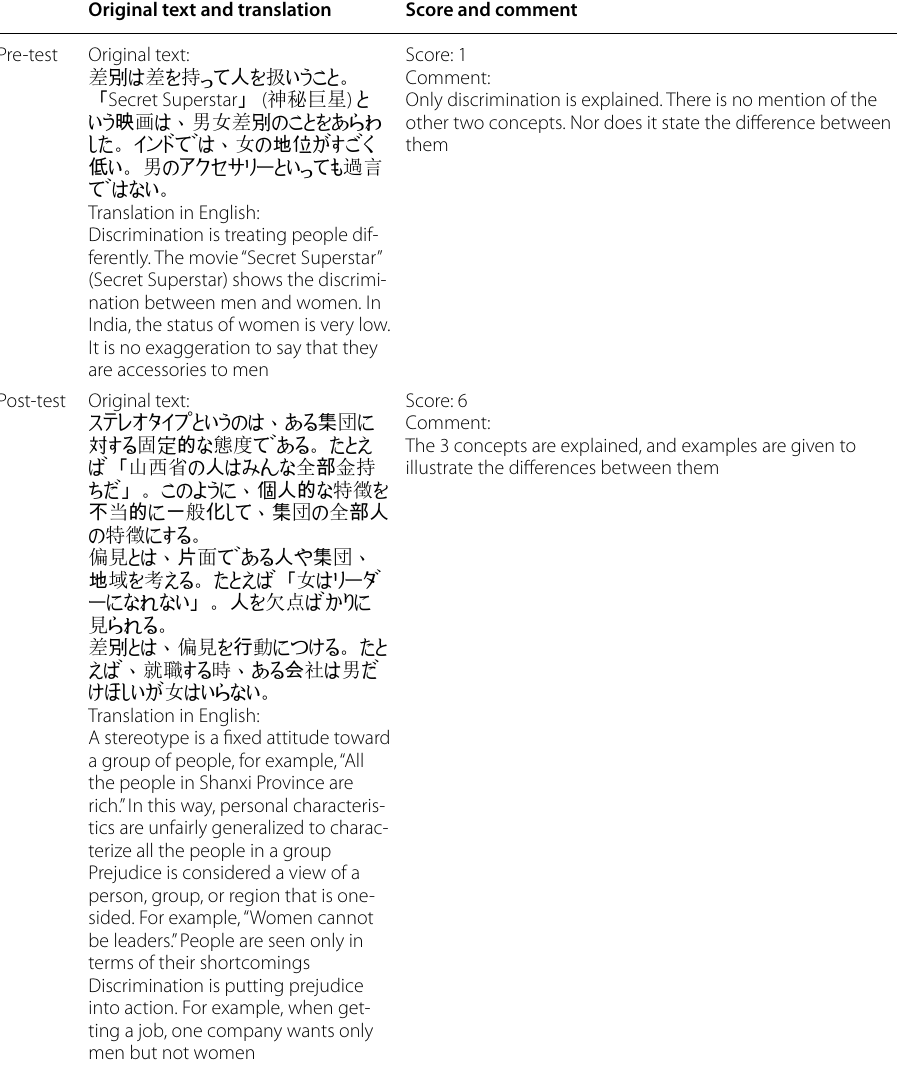
Table 5 Example of pre-post responses on the learning content Original text and translation Score and comment Pre-test